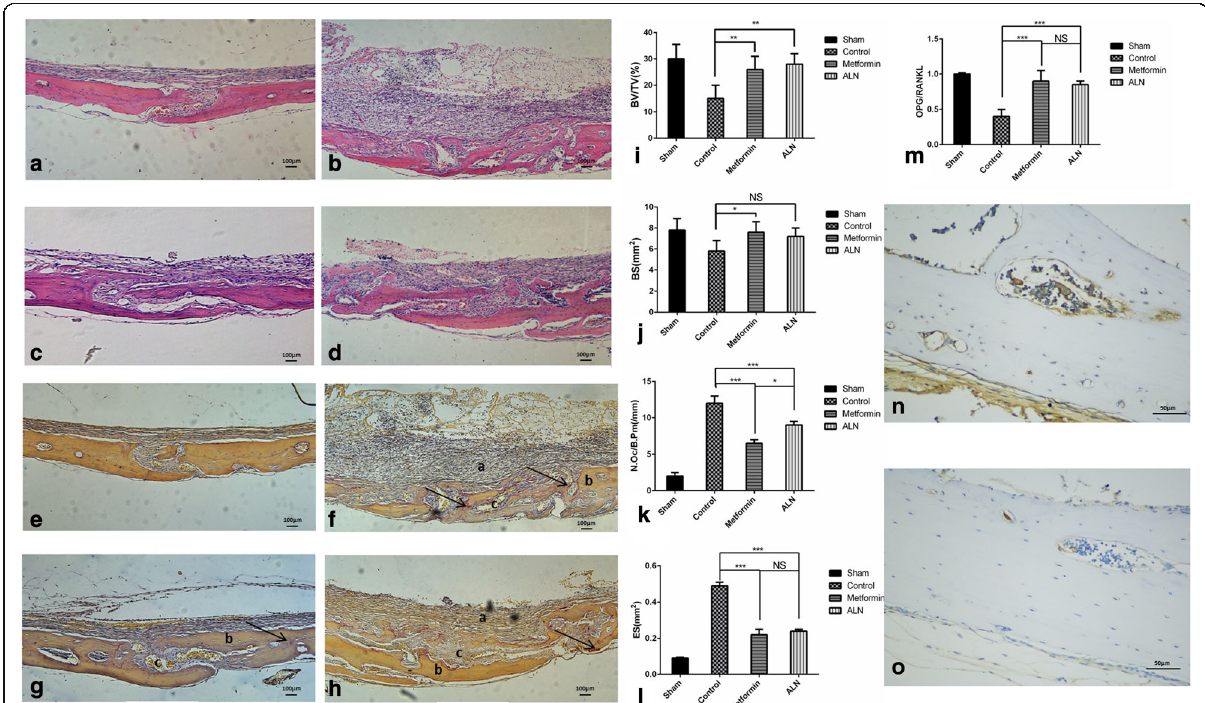
Fig. 4 Representative images of histological sections of harvested calvaria for evaluation of inflammatory infiltration and associated osteolysis after implantation of UHMWPE particles. Compared to the sham control group ( a ), inflammatory infiltrate and osteolysis was observed in calvaria implanted with UHMWPE particles ( b ). The inflammatory response was suppressed by treatment with metformin ( c ) or ALN ( d ). Representative images of TRAP staining of mouse calvarial tissue from the different groups ( e – h ). a, inflammatory tissue, b, bone tissue, c, erosion area, arrow, osteoclasts. Quantitated bone histomorphometric analysis including BV/TV ( i ), bone surface area ( j ), average numbers of osteoclasts ( k ), and erosion surface area ( l ). m Expression of osteoclastic genes. Immunohistochemical staining for CD11b in control ( n ) and metformin-treated groups ( o ). Data are presented as means ± SD. *** P < 0.001; ** P < 0.01; * P < 0.05; NS, P >